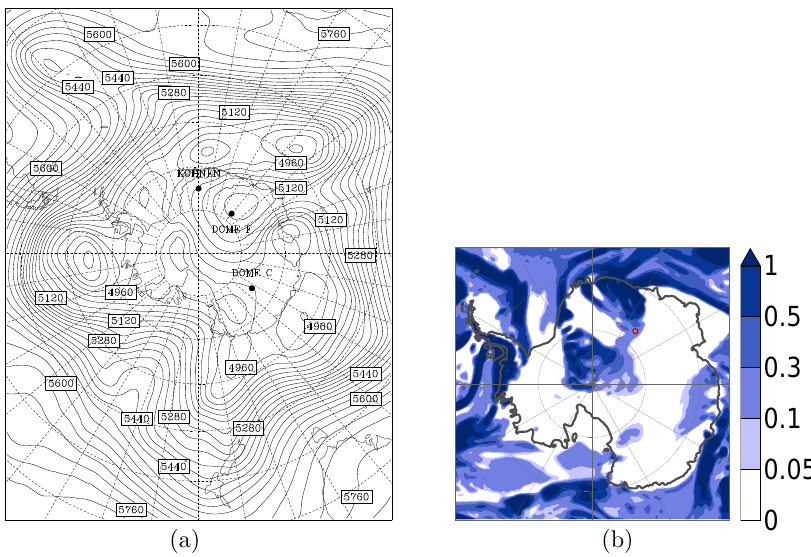
Figure 7. Example of a blocking high: (a) 500hPa geopotential height from AMPS, 3 November 2003 00:00UTC, (b) 6h precipitation in mm from AMPS, 3 November 2003